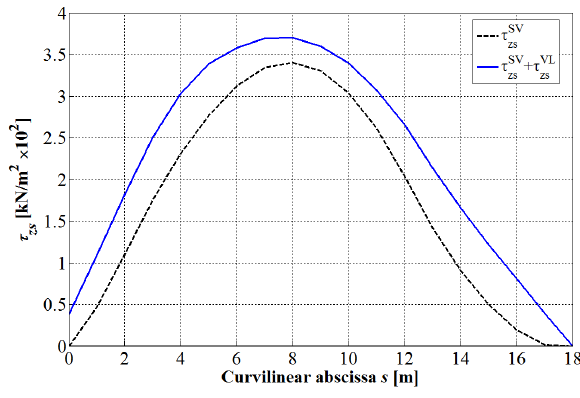
Figure 17: Tangential stresses acting on open shear wall no.